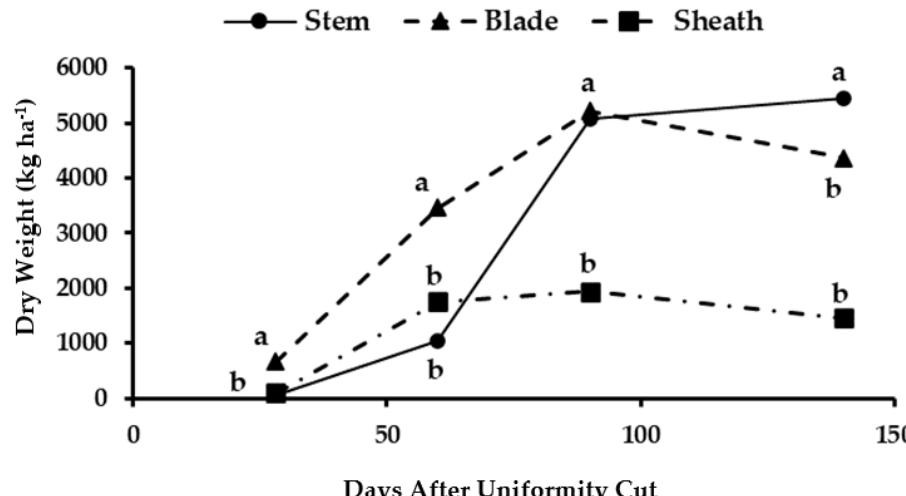
Figure 3. Dry biomass accumulation in different organs of the apical stratum of maralfalfa plants harvested at different cutting dates. The weight values with equal letters in each stratum of the plant were statistically similar ( p ≤ 0.05).